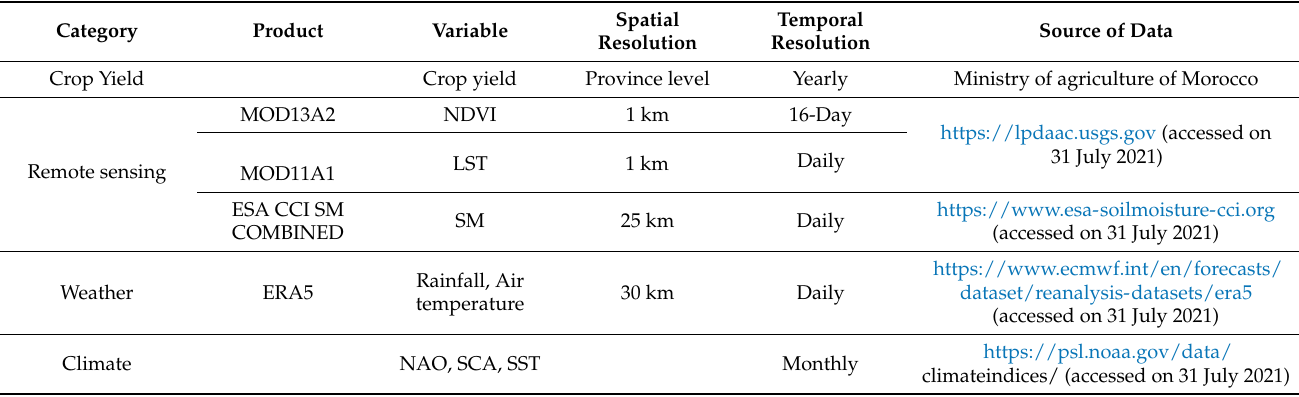
Table 1. Summary of the raw characteristics of the data sets used for yields prediction as well as yields “observations” information. All the datasets used for yields prediction are then averaged at the agricultural province and the monthly time scales (see text).